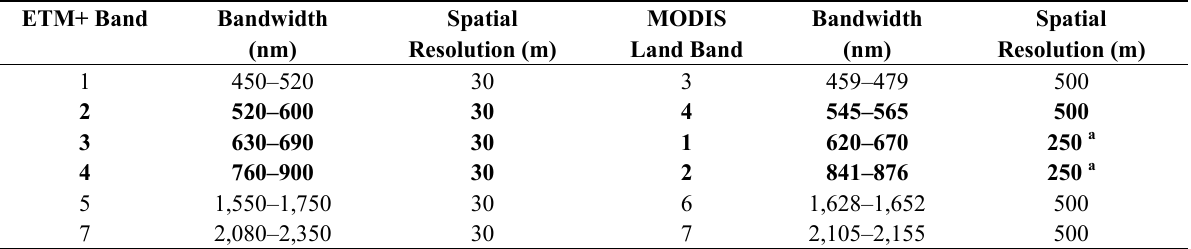
Table 2. Landsat Enhanced Thematic Mapper Plus (ETM+) bandwidth and Moderate Resolution Imaging Spectroradiometer (MODIS) land bandwidth. Three bands for testing are marked in bold.